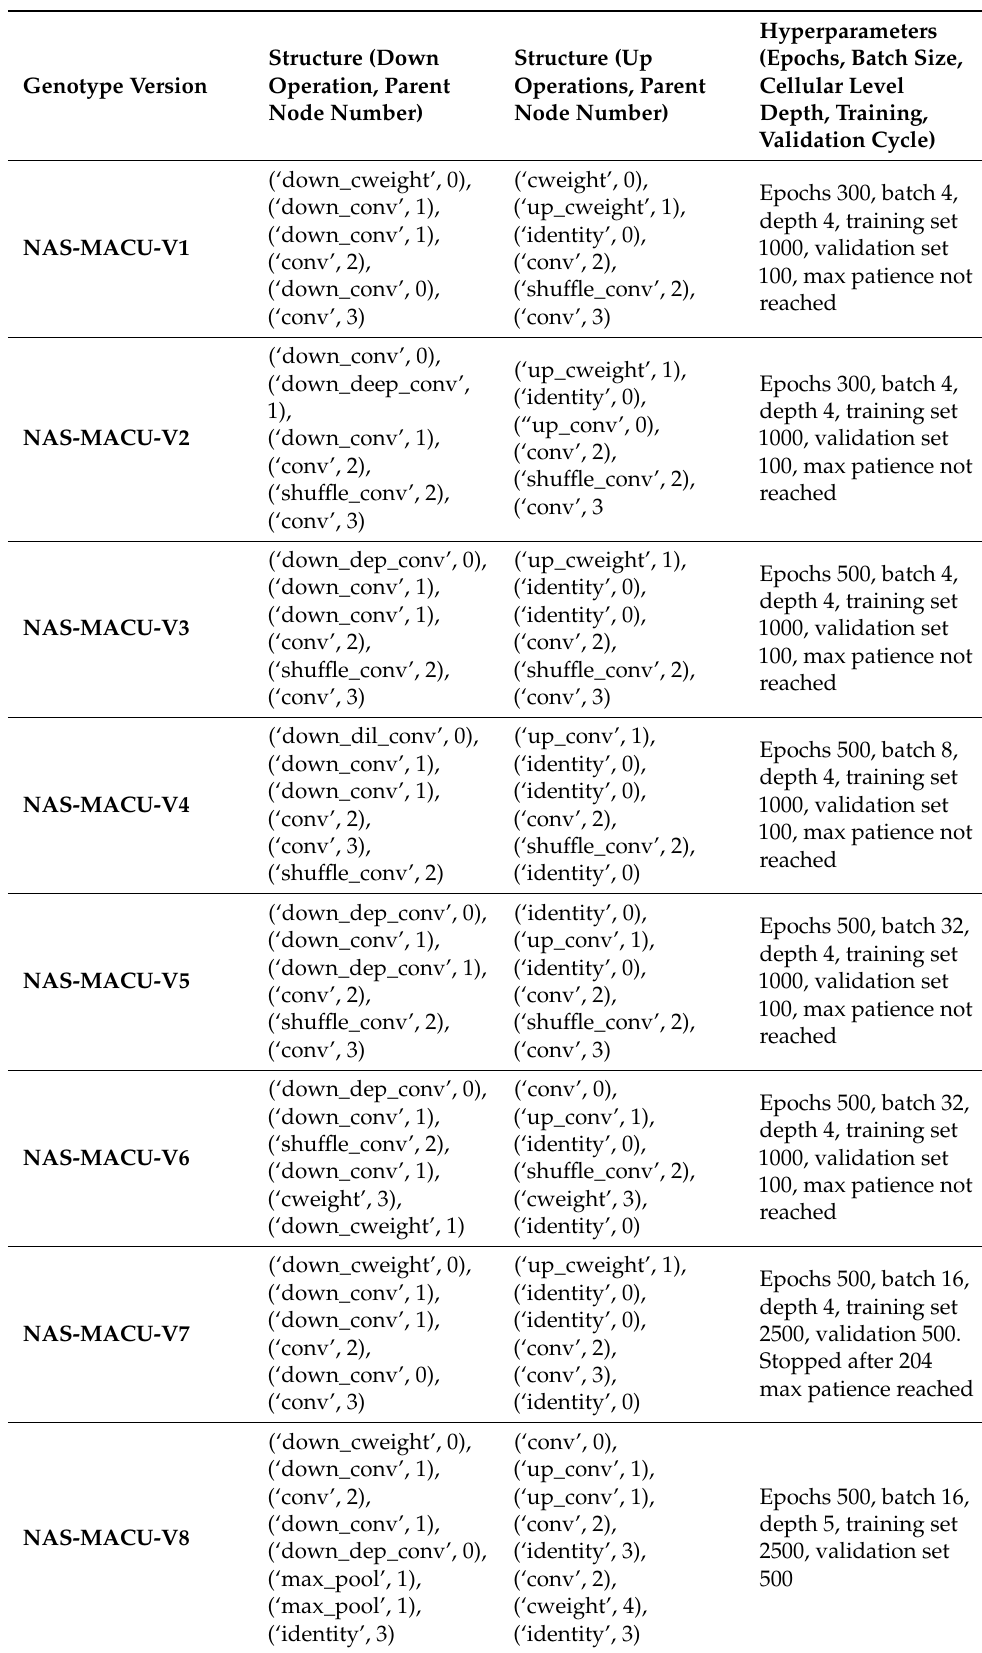
Table 4. NAS-MACU genotypes list, detailed by structure and